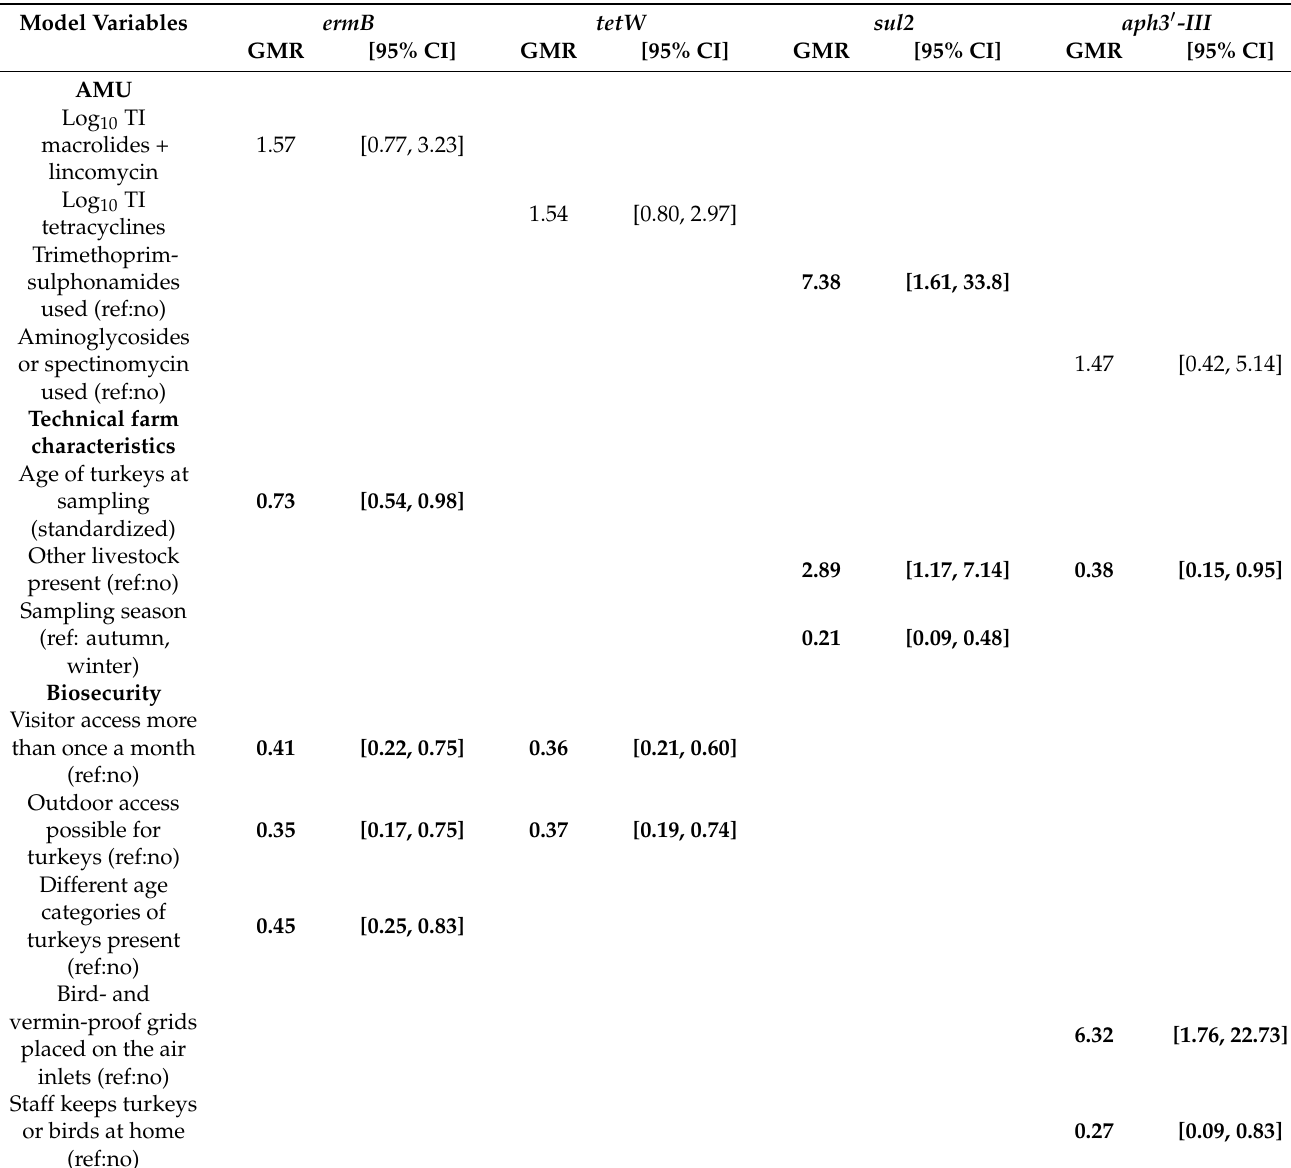
Table 3. Multivariable model associations between antimicrobial usage (AMU), characteristics, biosecurity measures of the turkey farms, and the median relative faecal abundance of ermB , tetW , sul2 , and aph3 (cid:48) -III per